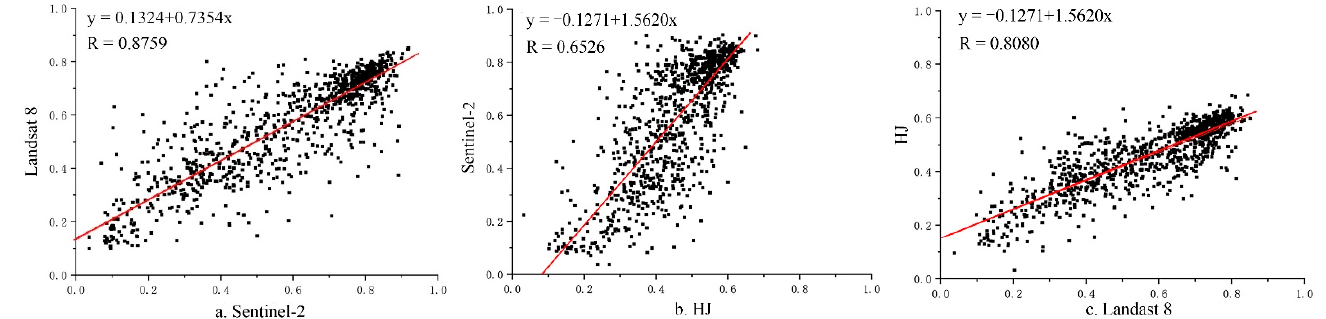
Figure 10. Correlation analysis of NDVI value based on random points (The figures include the conversion equation and correlation coefficient between every pair of sensors for NDVI. ( a ) shows the fitting result of NDVI between Landsat 8 and Sentinel-2; ( b ) shows the fitting result of NDVI between Sentinel-2 and HJ; ( c ) shows the fitting result of NDVI between HJ and Landsat 8). Table 6. The NDVI fitting results of the Inner Dump under multi-source sensor monitoring.